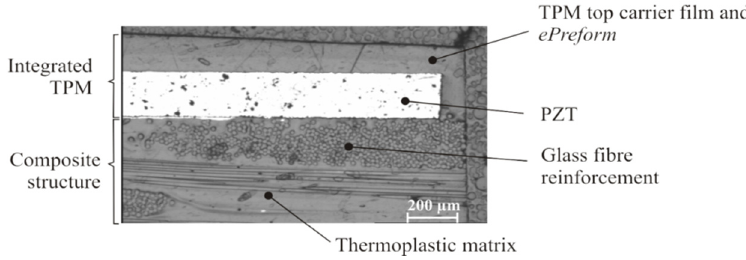
Figure 8. Micrograph of a matrix homogeneous integrated TPM.